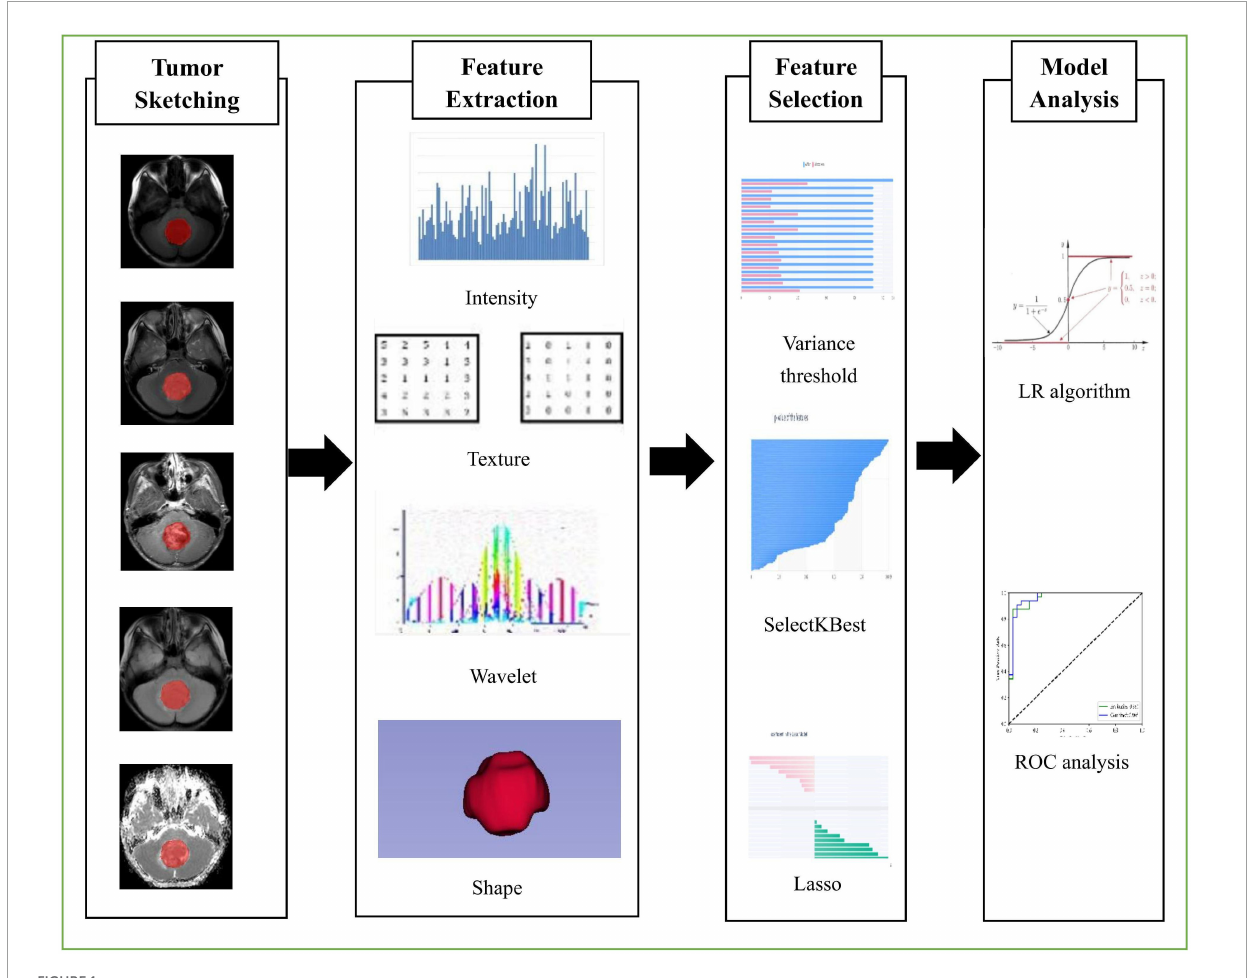
FIGURE1 Flowchart shows the process of radiomics in this study, including tumor sketching, feature extraction, feature selection, and model